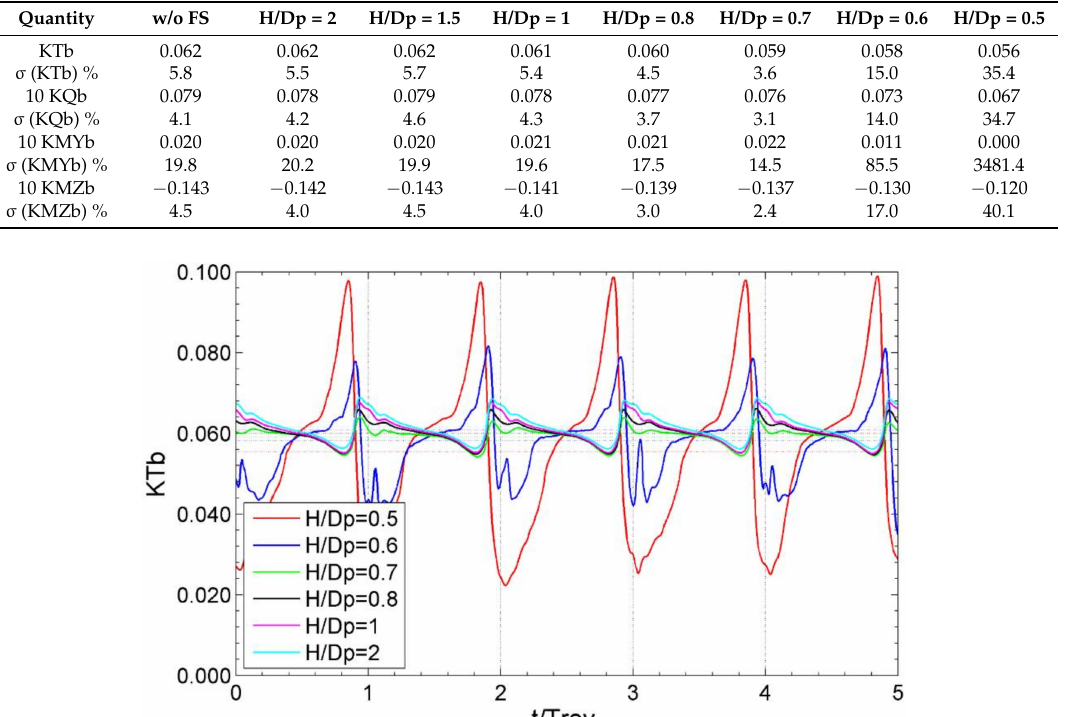
Figure 23. Computed time histories of single blade thrust, KTb, for different magnitudes of submergence, H/Dp, at J =